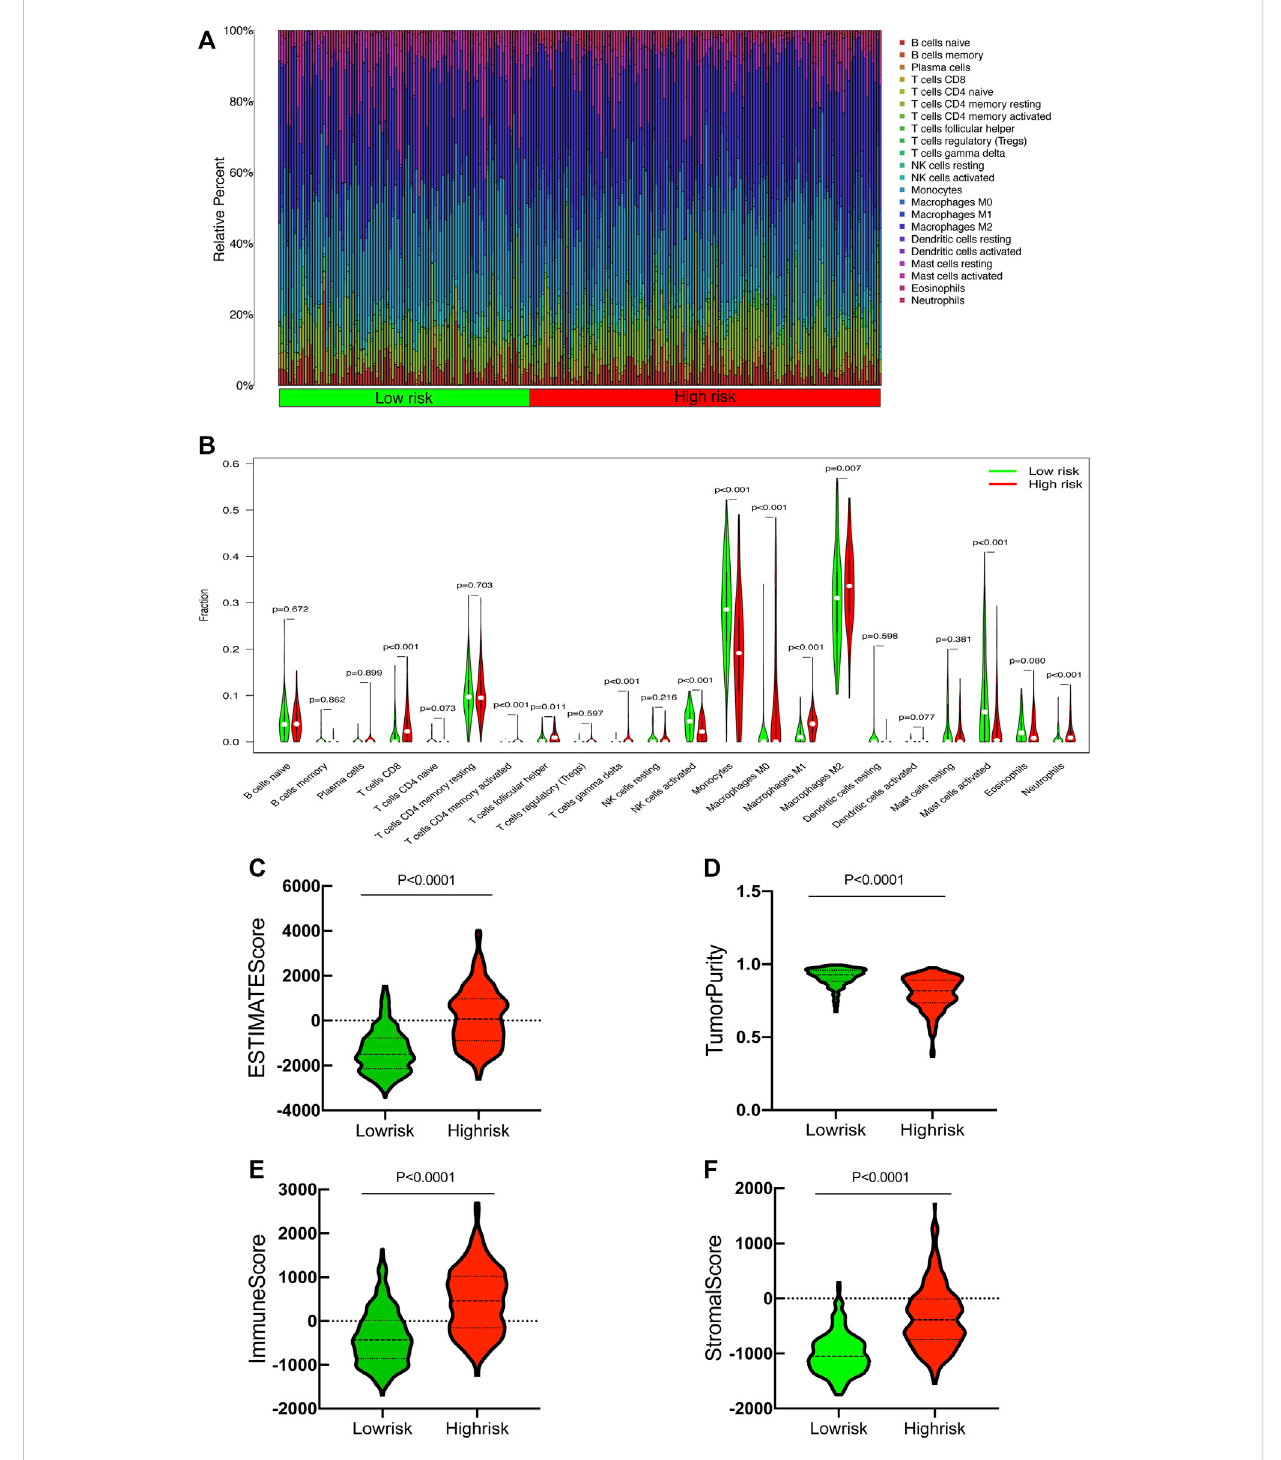
FIGURE 9 Correlation between tumor-in fi ltrating immune cells and risk prognosis signature. (A) The proportion of 22 immune cell subtypes. (B) The correlation between the signature and 13 immune-related functions. (C – F) Estimate immune in fi ltrating score.